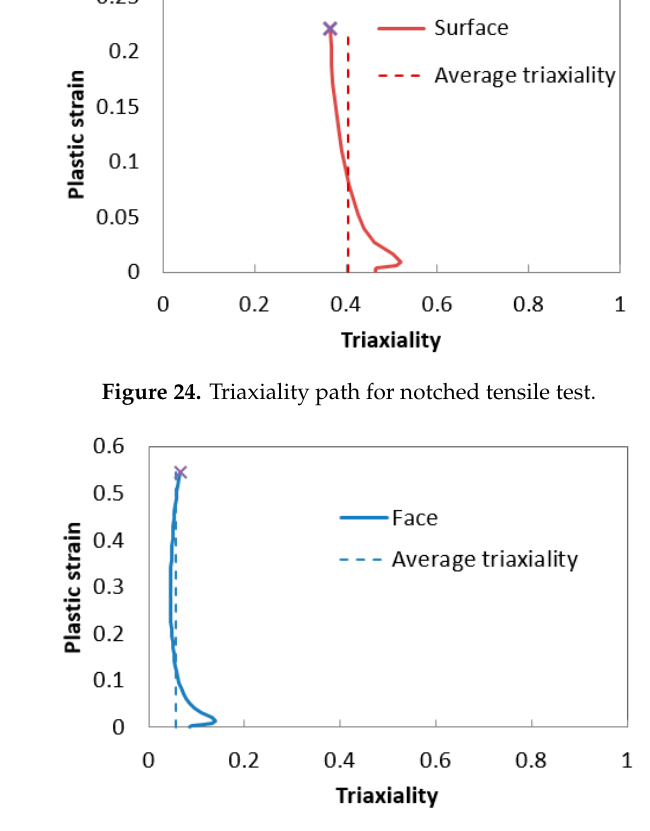
Figure 25. Triaxiality path for shear test.